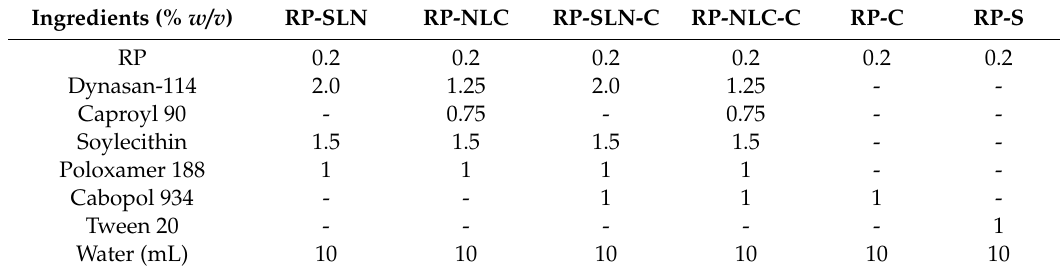
Table 1. Composition of ropinirole loaded solid lipid nanoparticles (SLN), nanostructured lipid carriers (NLC), hydrogel and control